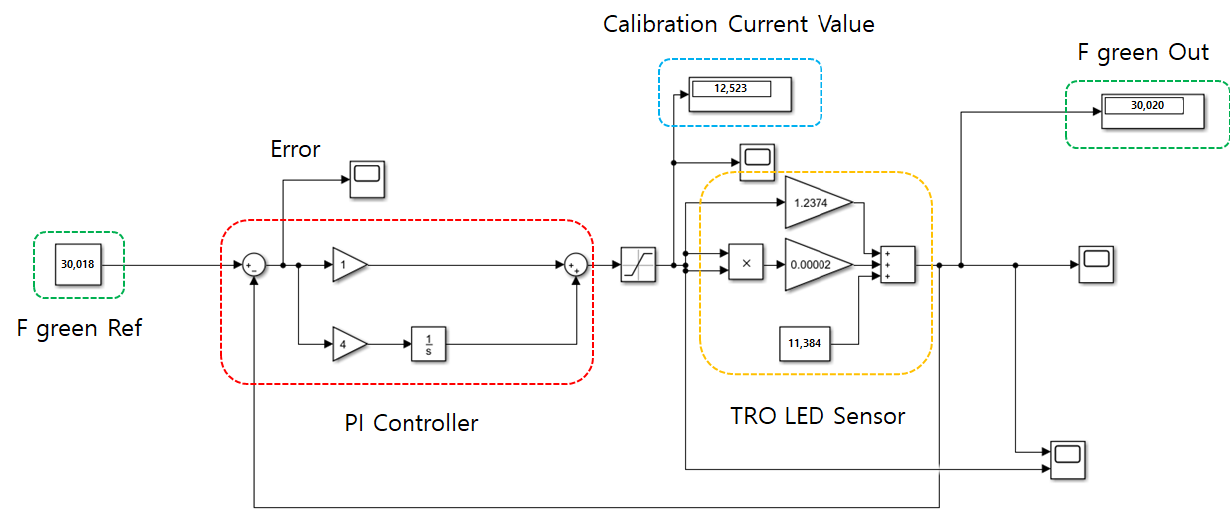
Figure 6. Proposed control algorithm for LED module calibration